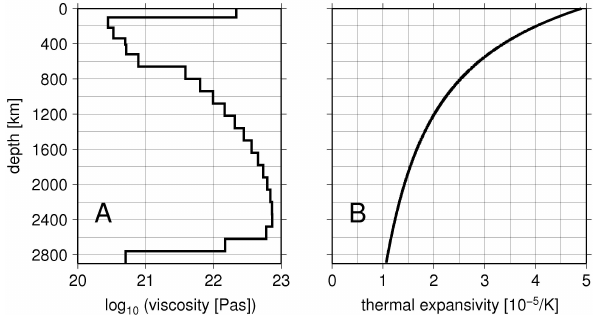
Fig. 1. Radial profiles of viscosity ( (A) ; from Steinberger and Calderwood, 2006) and thermal expansivity ( (B) ; lower mantle pro- file from Steinberger and Calderwood, 2006, extended to the upper mantle). The shape of the viscosity profile in each layer (upper man- tle, transition zone, lower mantle) has been inferred from mineral physics, and absolute viscosity values in each layer are adjusted to optimize fit to geoid and global heat flux (for a flow model based on seismic tomography) and satisfy the “Haskell” constraint from postglacial rebound (Mitrovica,